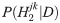
Posterior distribution of probability to change altitude.Figure shows the computed probability distribution p(θ|D, B2jk) of the reference bird ‘Four’ switching to a lower altitude when encountering ‘Milkyway’. The red dashed line indicates the mean of the posterior distribution, i.e. the predicted probability P(H2jk|D).